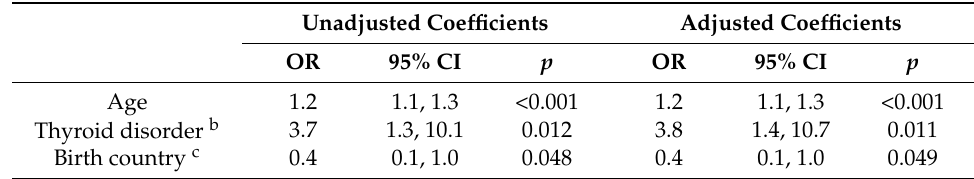
Table 6. Attributes associated with being in the highest tertile of knowledge score among young Norwegian women ( n = 392) a